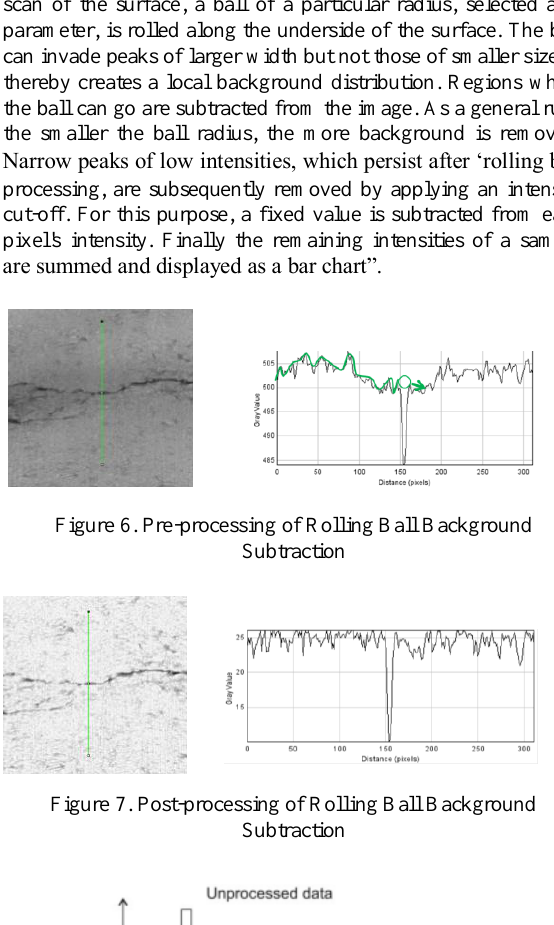
Figure 8. Rolling Ball Background Subtraction diagram